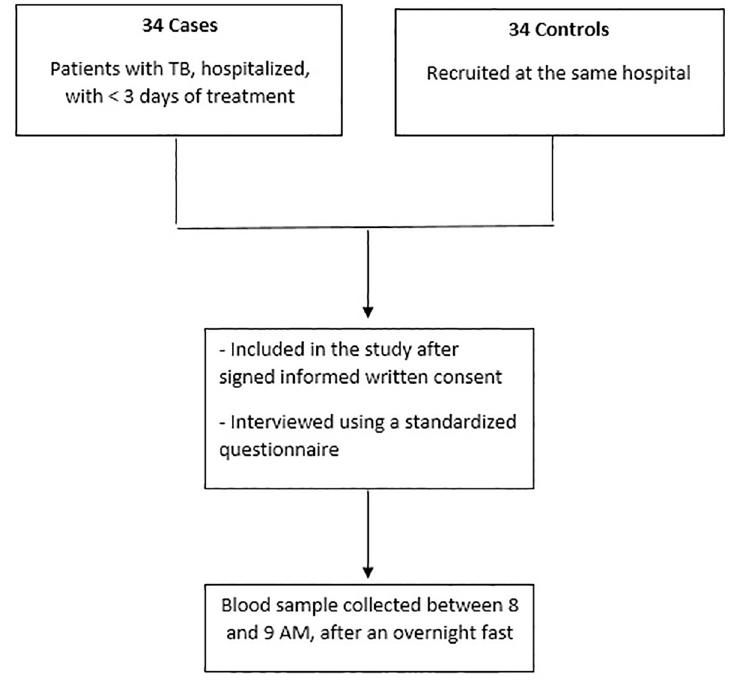
Fig 1. Flow chart of patients included in the study.